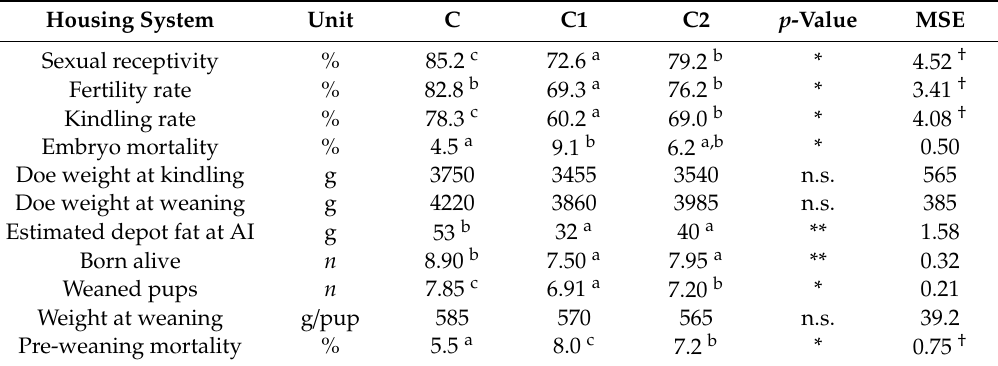
Table 4. E ff ect of housing system on reproductive performance of